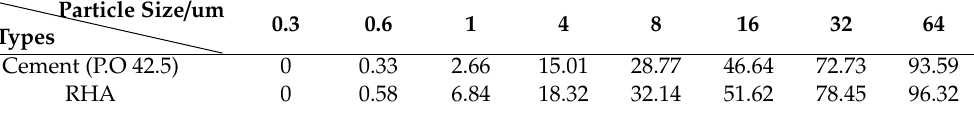
Table 1. Particle passing percentage of the cementitious